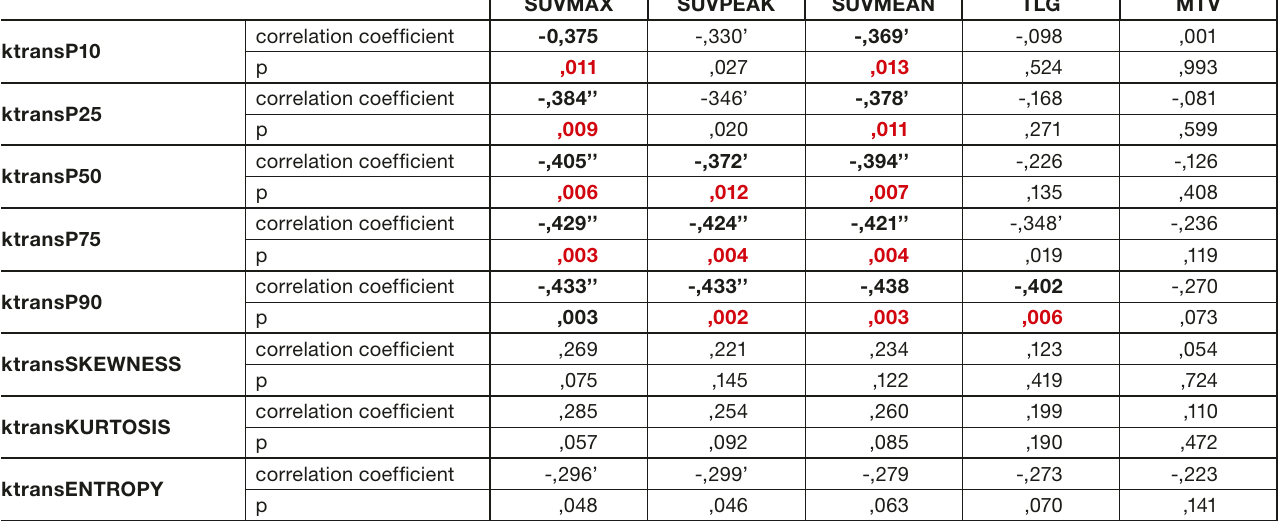
*significant correlations are in bold, corresponding p values are